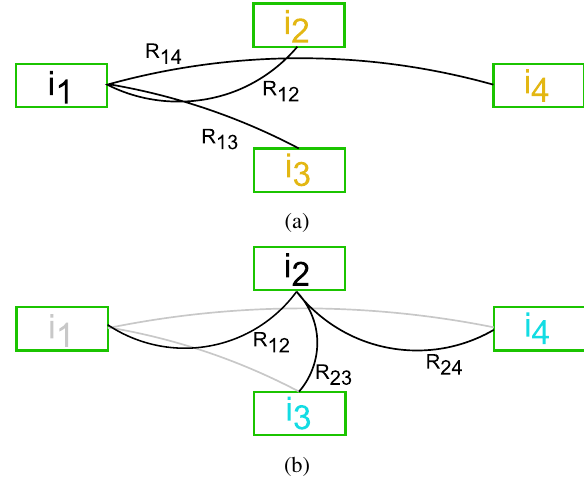
Figure 1: Graph structure during multiple rotation averaging de- picted for two phases of the first stage. (1a) shows propagation from image i 1 (black) in which all other nodes receive a rota- tion (orange). In (1b) propagation starts from image i 2 . i 1 does not receive a rotation since it is fixed (grey). i 3 and i 4 exhibit an assigned value and underlie outlier detection and averaging